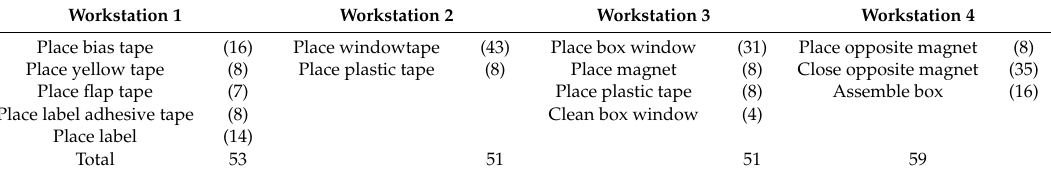
Table 6. Redesign of activities for the box assembly